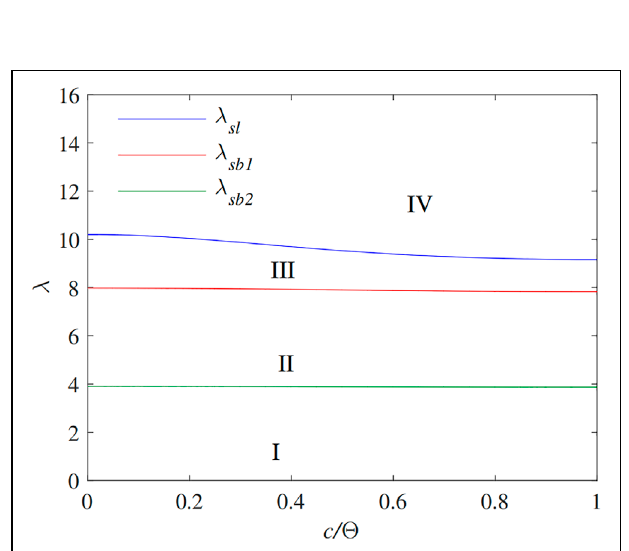
FIGURE 9 | Equilibrium paths of limit point instability for pin-ended FGM arches using different localized parameters: (A) v / f − Q /(2 N Ec2 Θ ) curves. (B) N / N Ec2 − Q /(2 N Ec2 Θ ) curves.